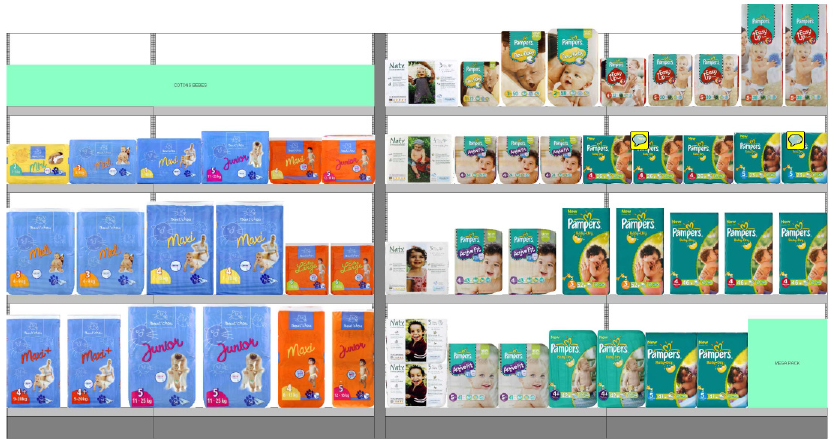
Figure 5. Example of a planogram used in the retail market and described by an XML file.